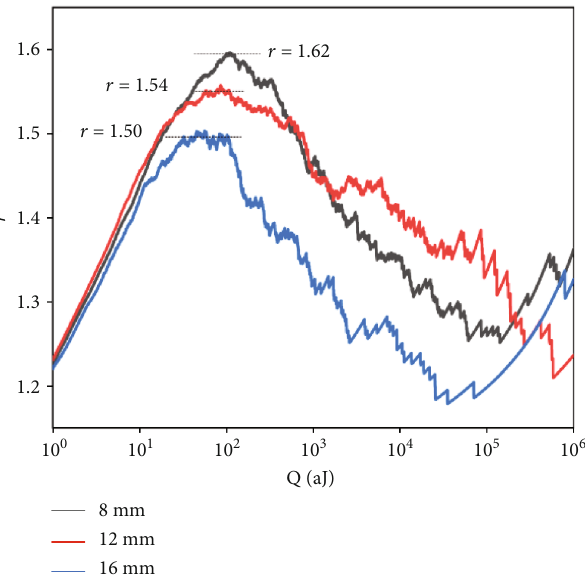
Figure 8: Maximum likelihood estimation of acoustic emission energy power law